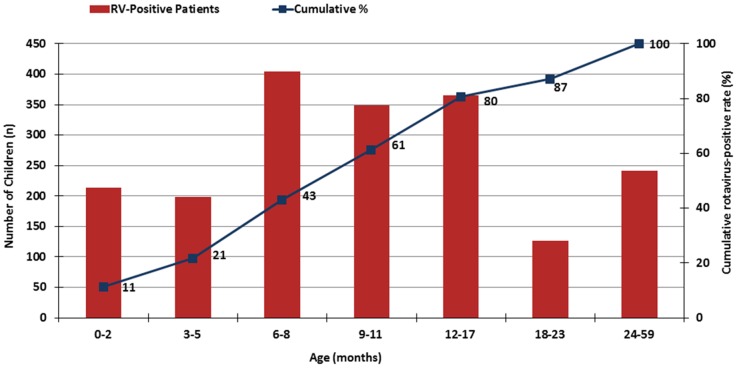
Cumulative age distribution of children less than 5 years of age admitted with severe diarrhea at five sentinel hospitals in Pakistan, 2006–2008.Bars represent number of children with rotavirus- positive diarrhea. Points represent cumulative rate (%) of rotavirus- positive gastroenteritis.